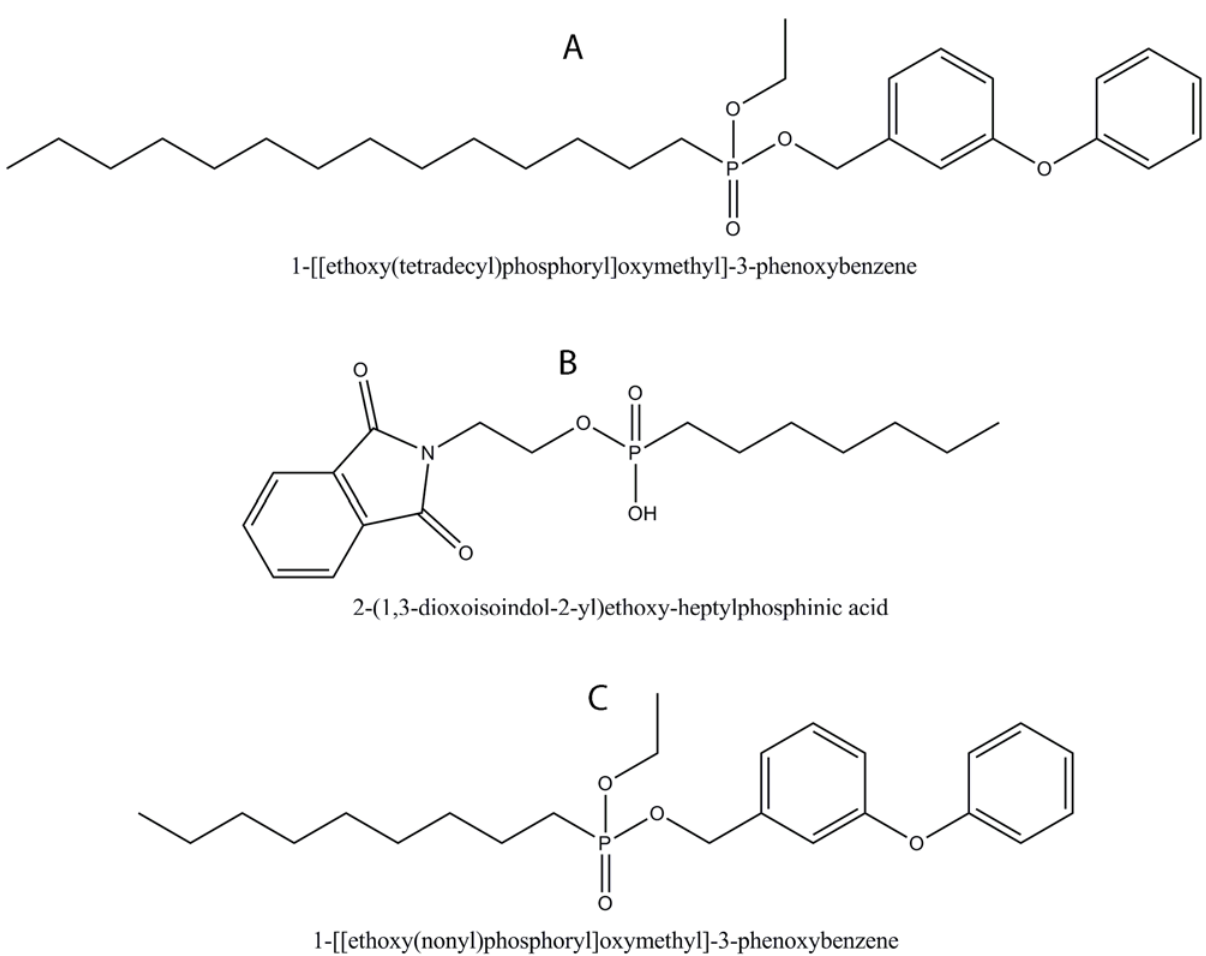
Fig 2. Structure of Top Extracted Compounds by in silico Screening. (A) 1-[[ethoxy(tetradecyl)phosphoryl]oxymethyl]-3-phenoxybenzene (C1), (B) 2- (1,3-dioxoisoindol-2-yl)ethoxy-heptylphosphinic acid (C2), (C) 1-[[ethoxy(nonyl)phosphoryl]oxymethyl]-3-phenoxybenzene